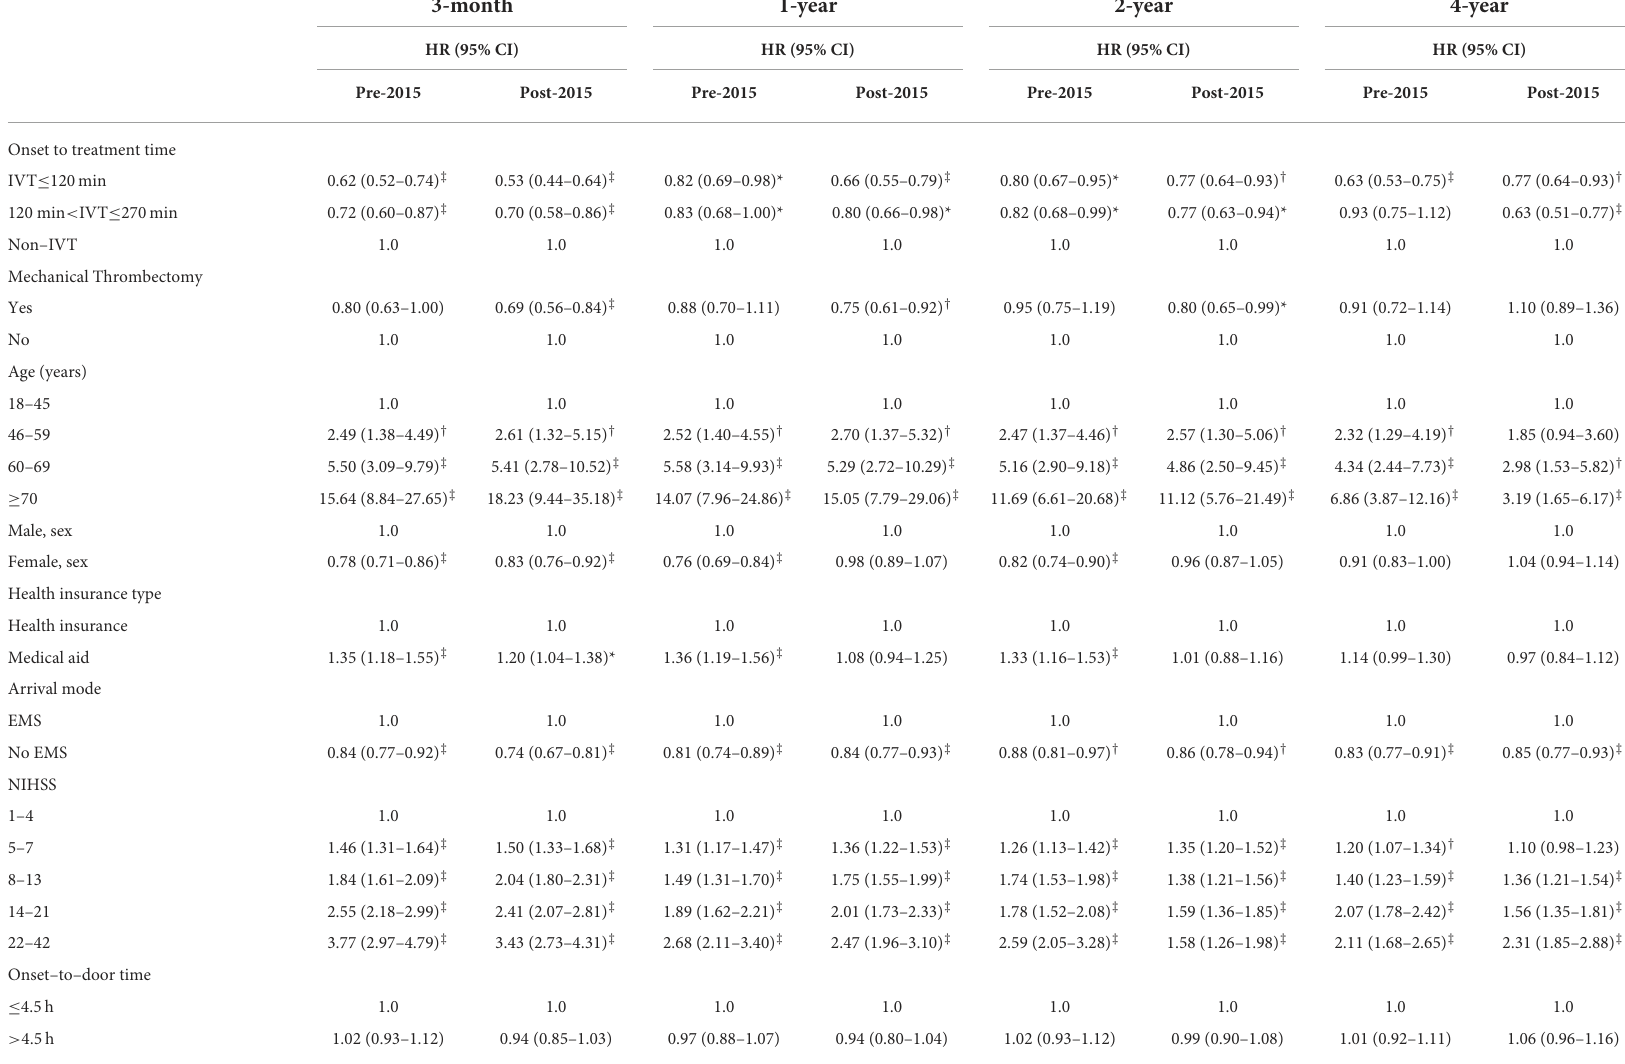
TABLE 2 Comparison of multivariable cox regression on survival between pre-2015 and